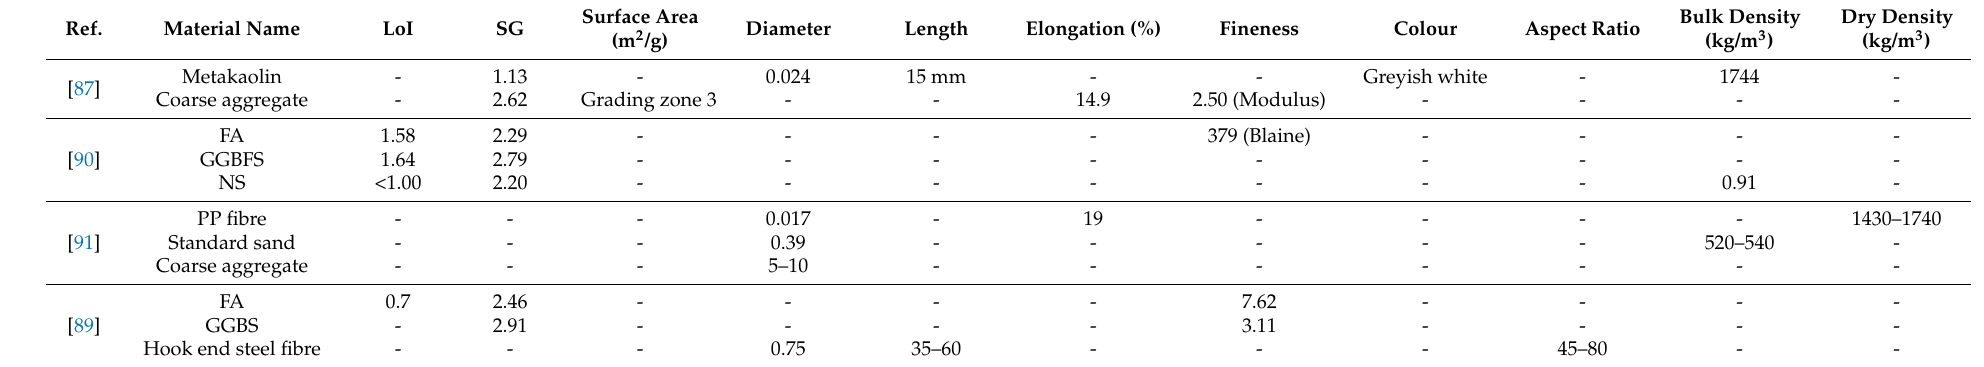
Table 2. Physical properties of various